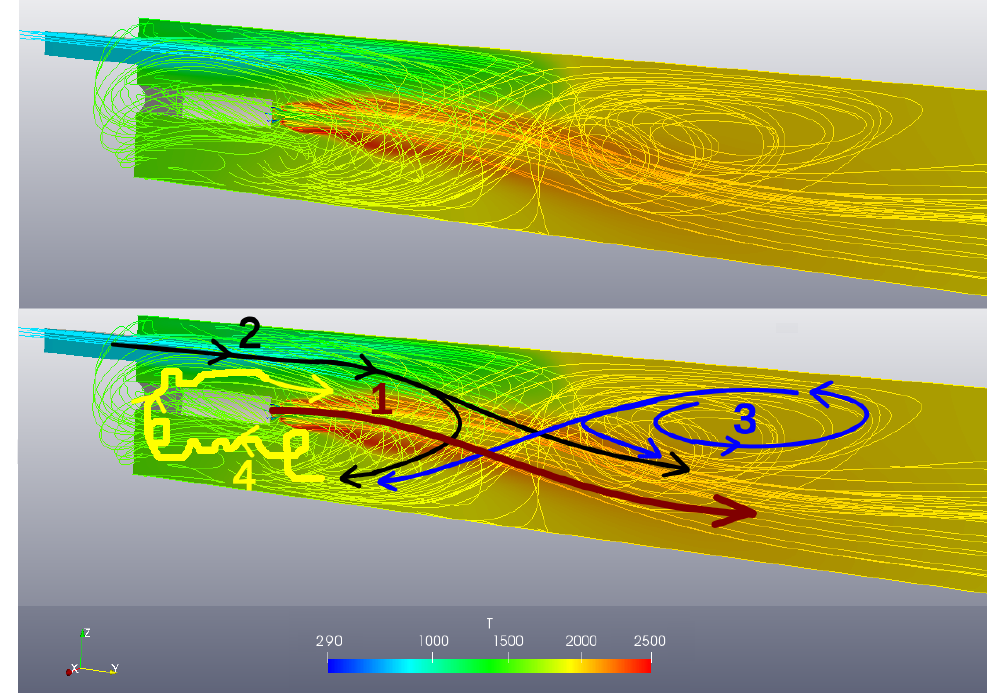
Figure 4. Stream pattern and temperature contour plot of the kiln geometry